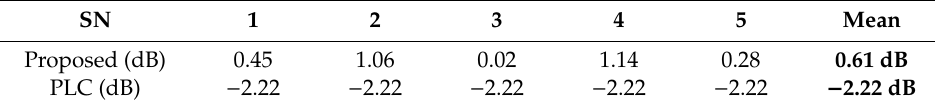
Table 7. RRSs of the false targets in green